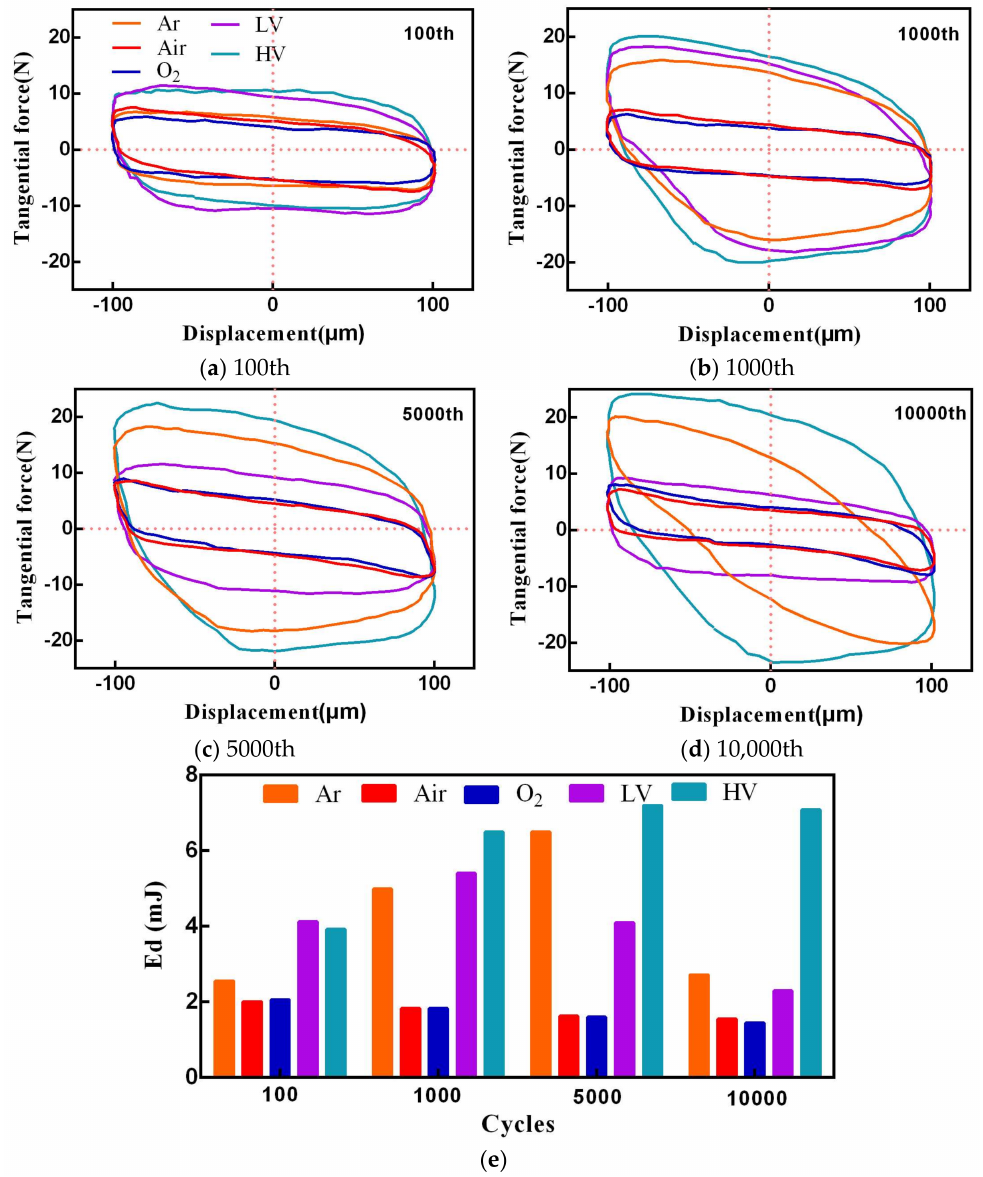
Figure 4. Evolution of fretting loops with cycle number under different atmosphere and vacuum conditions ( a – d ) and Ed of each cycles ( e